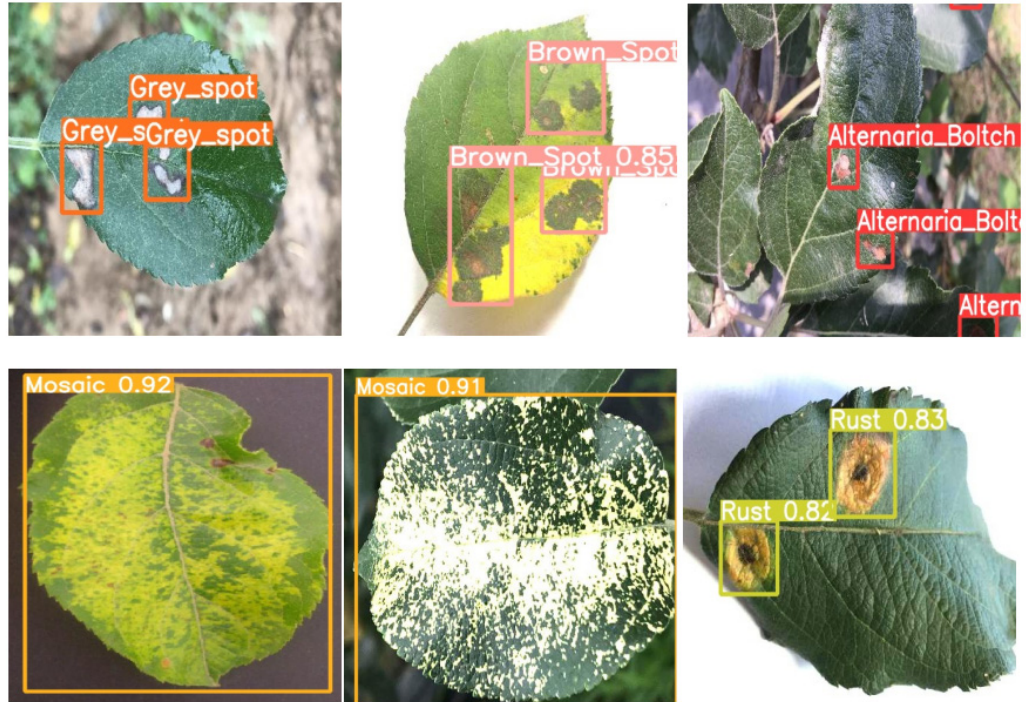
Figure 17. Apple leaf disease detection images.